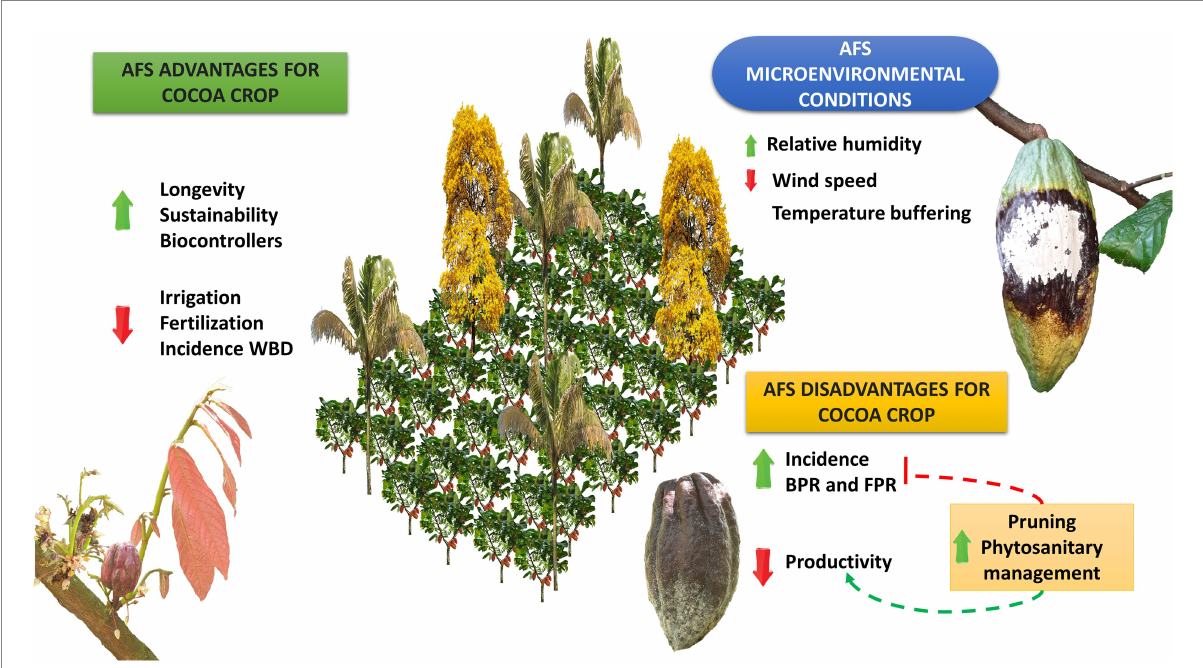
FIGURE 2 Impact on the development of diseases and cacao productivity in agroforestry systems as compared to monoculture. Green arrows mean a favored process and red arrows mean an unfavorable process. AFS promotes specific changes in the cocoa microenvironment, especially related to higher humidity and potentially a greater buffering of temperature changes, despite it may reduce the wind speed inside the system. These changes have the potential to induce an increase in the longevity of cocoa plants, better use of pest and disease biocontrollers, and ultimately promote environmental sustainability. In addition, it may promote a lower need for irrigation and fertilization, as well as a lower incidence of witch’s broom disease (WBD), impacting positively the producers’ costs. However, in parallel AFS models have a great potential to negatively impact cocoa productivity due to higher susceptibility to black pod rot (BPR) and frosty pod rot (FPR) if pruning and phytosanitary management are not carried out